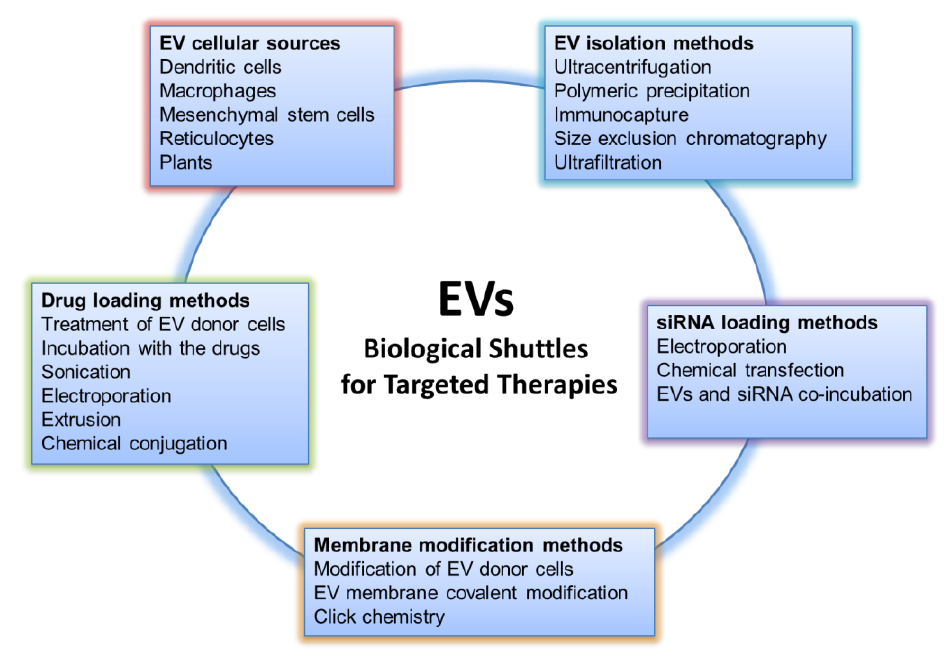
Figure 1. Aspects to be considered for the use of Extracellular Vesicles as drug delivery systems.